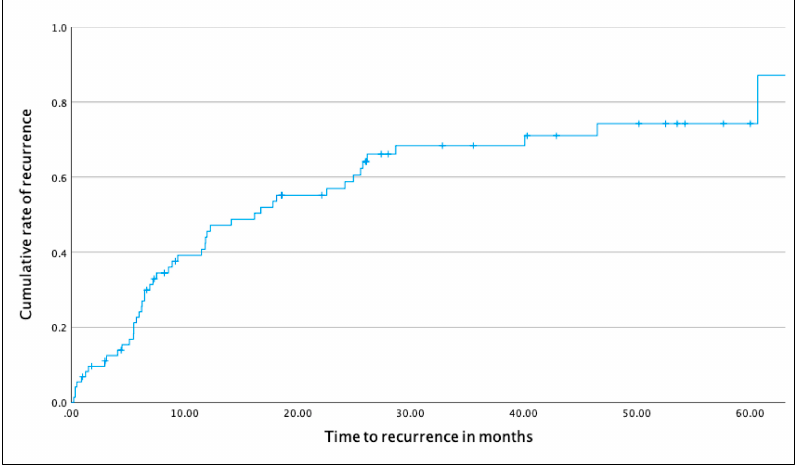
Figure 1. Kaplan–Meier survival curve showing the cumulative rate of recurrence over time (data censored at 60 months).